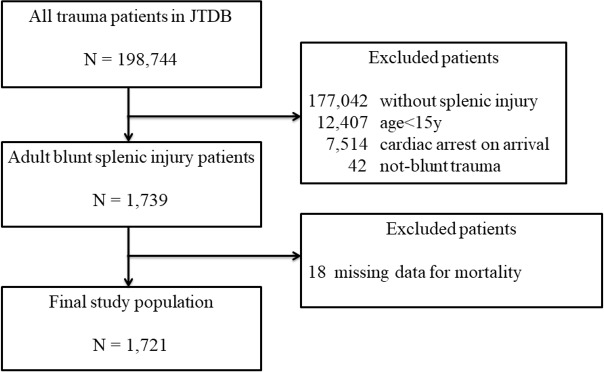
Patient selection.